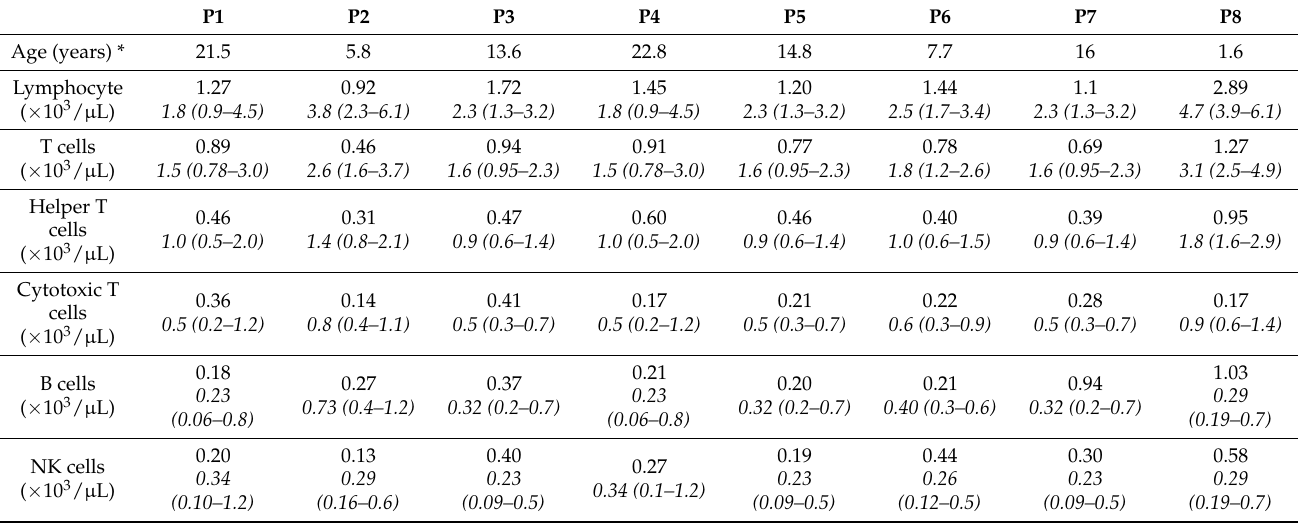
Table 2. Lymphocyte subsets of the